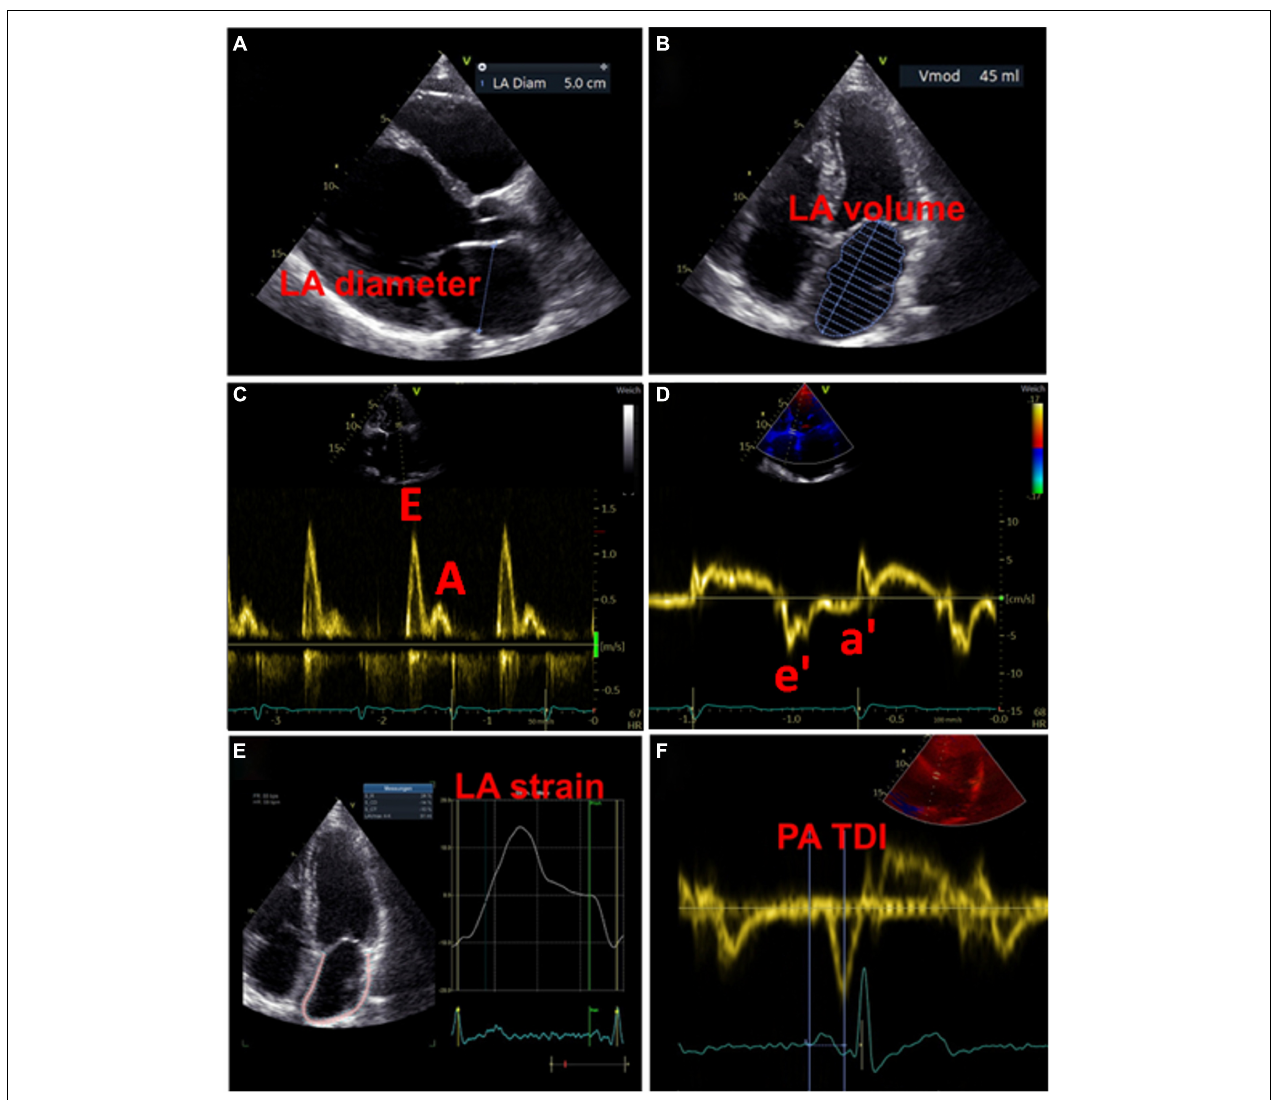
FIGURE 3 | Examples of echocardiographic measurements for the detection of left atrial cardiomyopathy. (A) Measurement of diameter in left atrial diastole. (B) Measurement of left atrial volume in left atrial diastole. (C) Transmitral inflow profile in left ventricular diastole: the first wave represents the E wave (passive inflow of blood into the left ventricle), the second wave represents the A wave (active contraction of the left atrium). (D) Tissue Doppler imaging of the movements of the left ventricular myocardium, in combination with the measurements from (C) the function of the atrium and the left ventricular end-diastolic pressure can be estimated. (E) Strain analysis of the left atrium. (F) Measurement of the PA-TDI interval from the beginning of the P-wave (as the onset of electrical activity of the atrium) to the peak of the a (cid:48) -wave (mechanical response of atrial